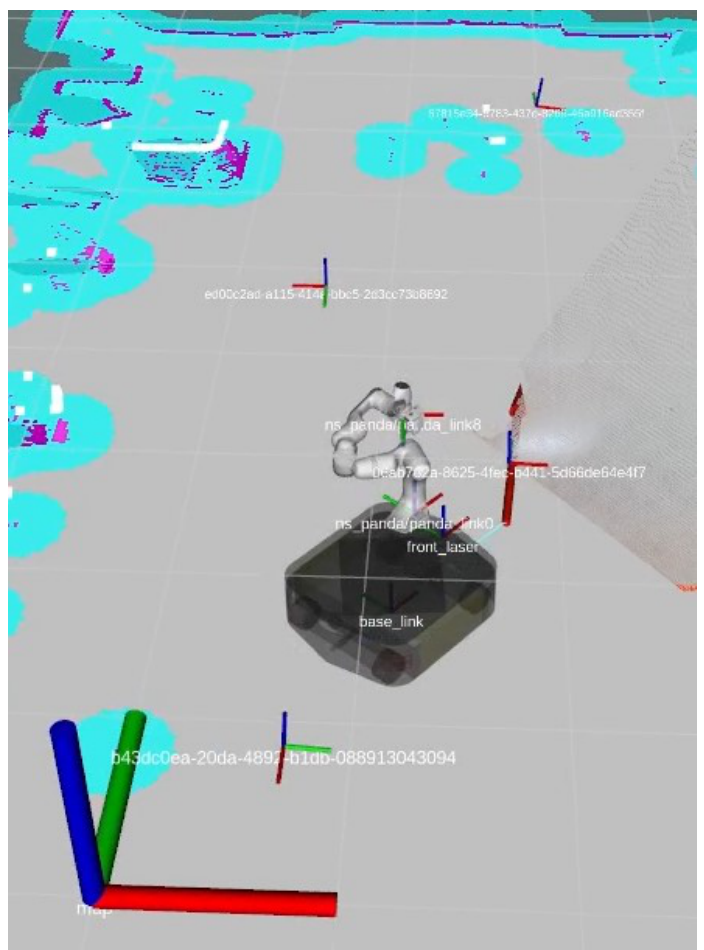
Figure 9. Anchor points placed along the path of the